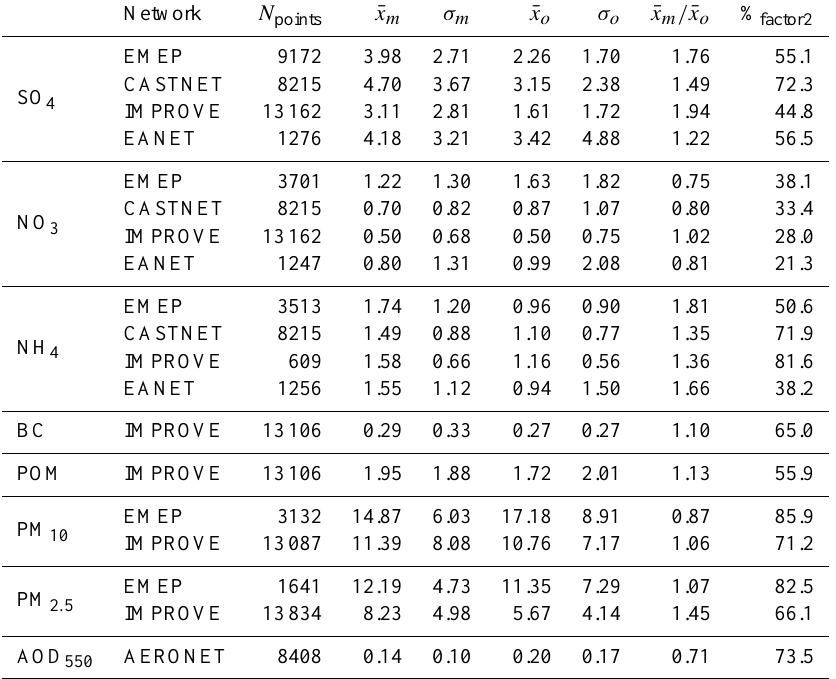
Table A1. Summary of the comparison between model ( m ) and observations ( o ) for aerosol concentrations (EMEP, CASTNET, IMPROVE, EANET) and aerosol optical depth (AOD) at 550nm (AERONET). Average ¯ x and standard deviation σ (in units of µgm − 3 , except AOD, which is dimensionless) are computed over all available observational data points N points in the time period 1996–2005. The standard devi- ation accounts for both temporal and spatial variations. % factor2 represents the percentage fraction of model data points showing simulated values within a factor of 2 of the observations. The different number of points for the different species is due to differences in station coverage and data